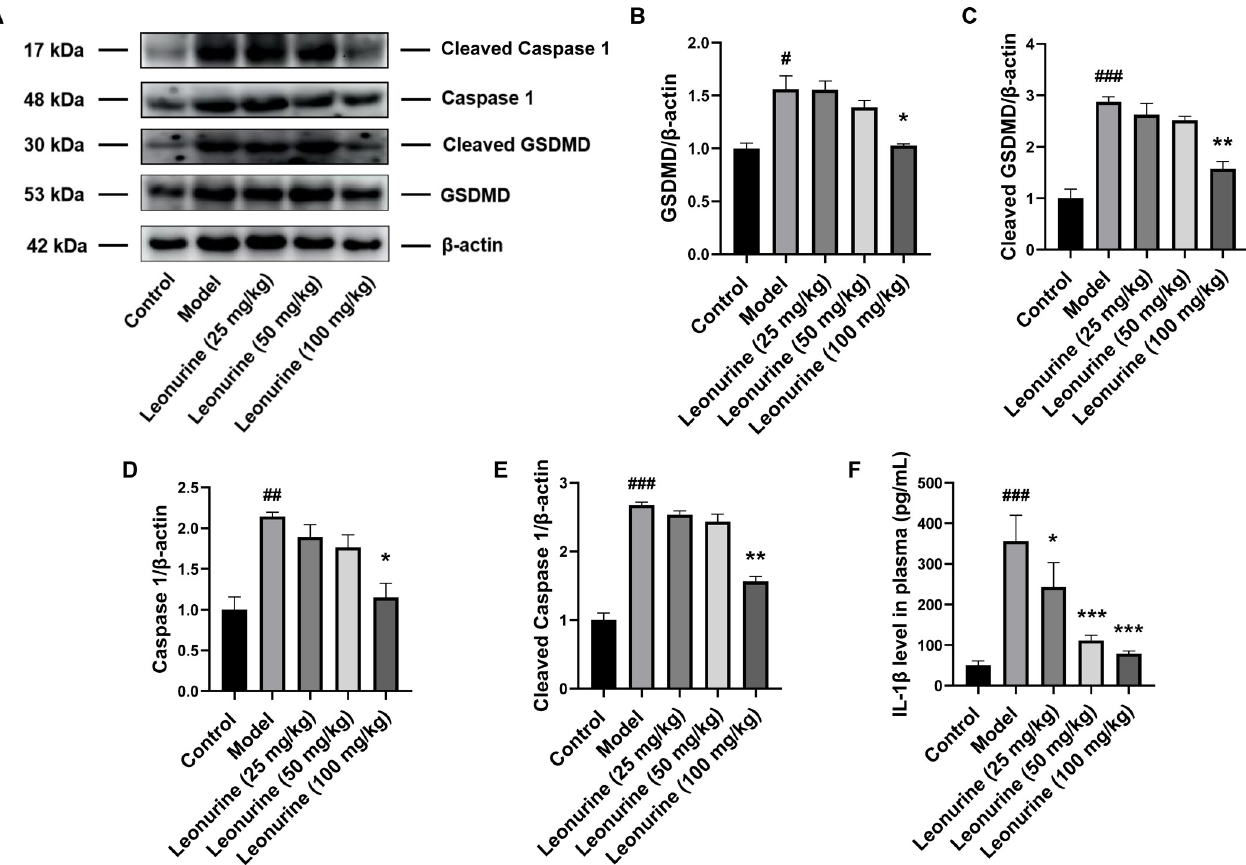
Fig 5. Leonurine reduced the expression of proteins related to pyroptosis in heart tissues from rats with ISO-induced heart failure. (A) Compared to ISO- induced rats, leonurine decreased expressions of pyroptosis proteins including (B) GSDMD, (C) cleaved GSDMD, (D) Caspase 1, (E) cleaved Caspase 1, and the level of (F) IL-1 β in plasma. #P < 0.05, ##P < 0.01, ###P < 0.001, model group vs. control group; � P < 0.05, �� P < 0.01, ��� P < 0.001, leonurine groups vs. model group.